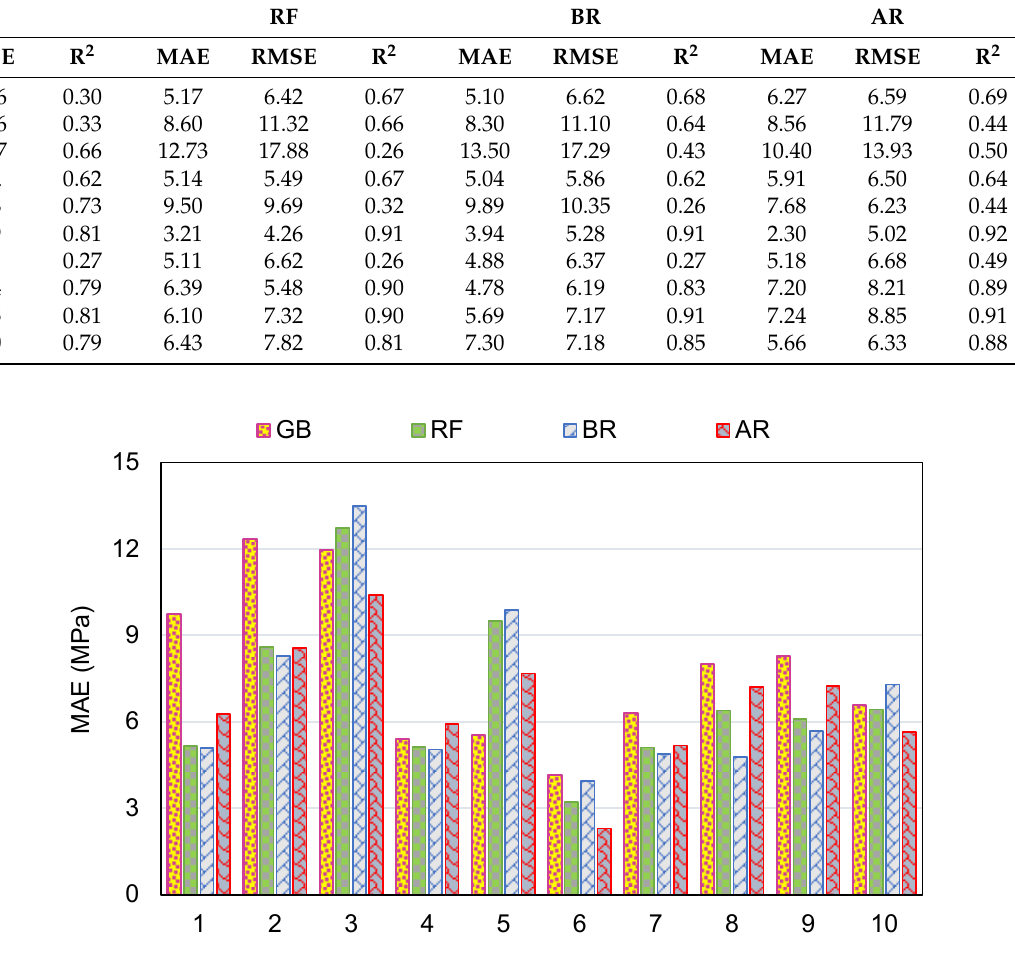
Table 3. MAE, RMSE, and R 2 results from the k-fold assessment.